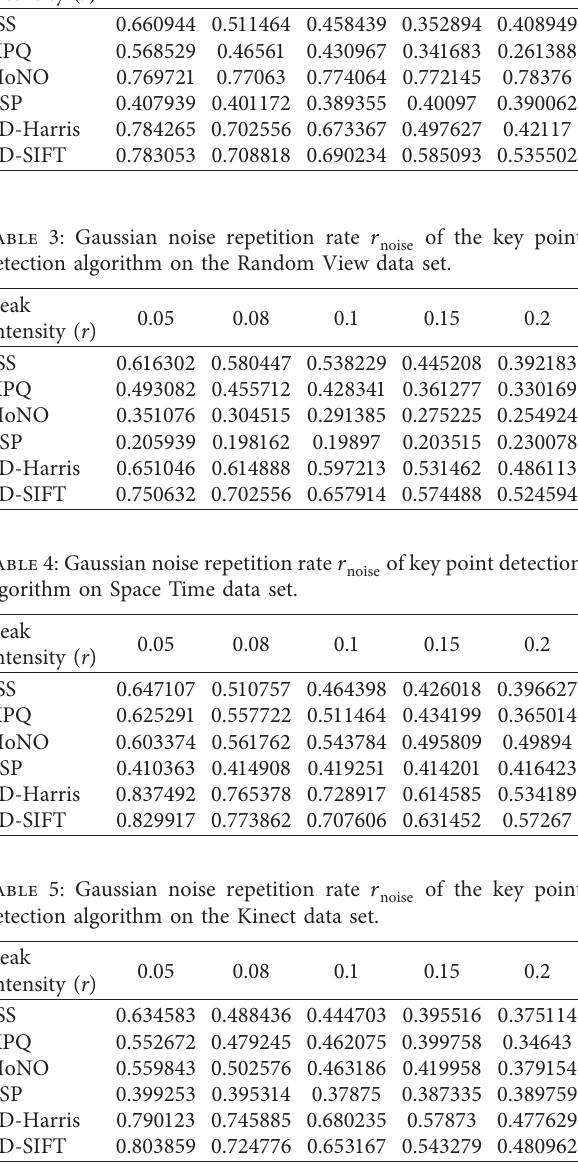
Table 2: Gaussian noise repetition rate r detection algorithm on the Laser Scanner data set.